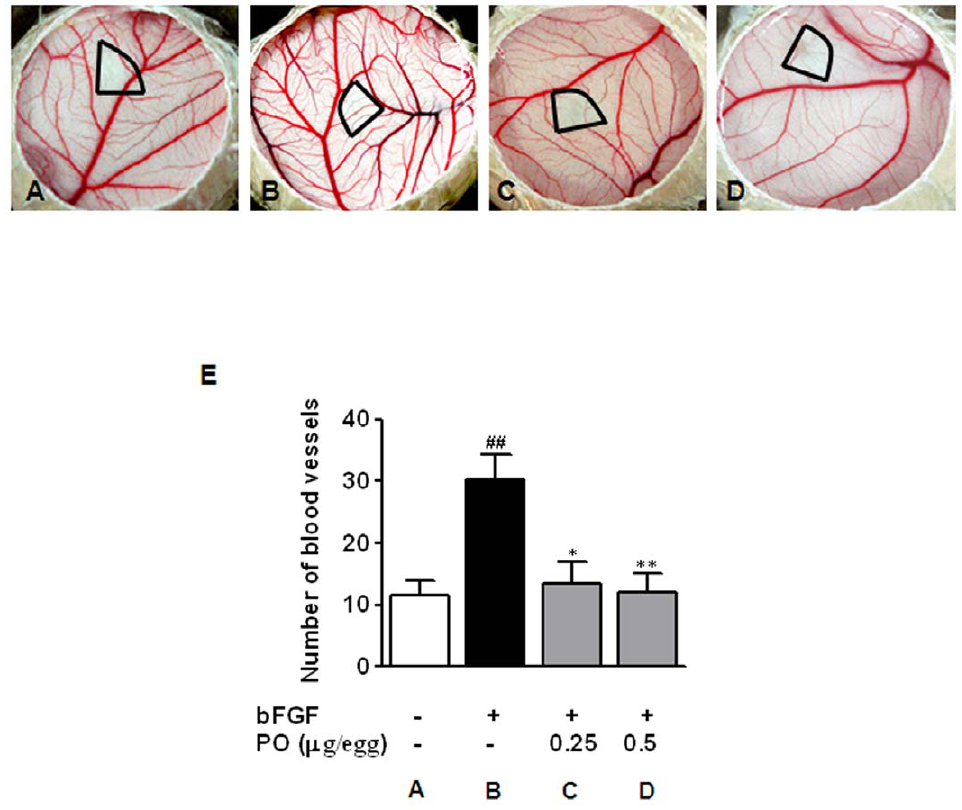
Figure 4. PO disrupts bFGF-induced angiogenesis invivo . PO and bFGF were loaded on CAMs of 10-day-old fertilized chicken eggs. After 72 h incubation, a fat emulsion was injected into the CAMs for better visualization of the blood vessels. Thermanox disc and surrounding CAMs were photographed. (A) Untreated control, (B) bFGF-treated control, (C) 0.25 m g of PO with bFGF, and (D) 0.5 m g of PO with bFGF. (E) The number of newly formed blood vessels per field was counted. All data are presented as mean 6 S.D., n =5. Statistically significant differences between control and sample groups were calculated by Student’s t -test. ## , p , 0.05 versus untreated control. * , p , 0.05 and *** , p , 0.001 versus bFGF control.